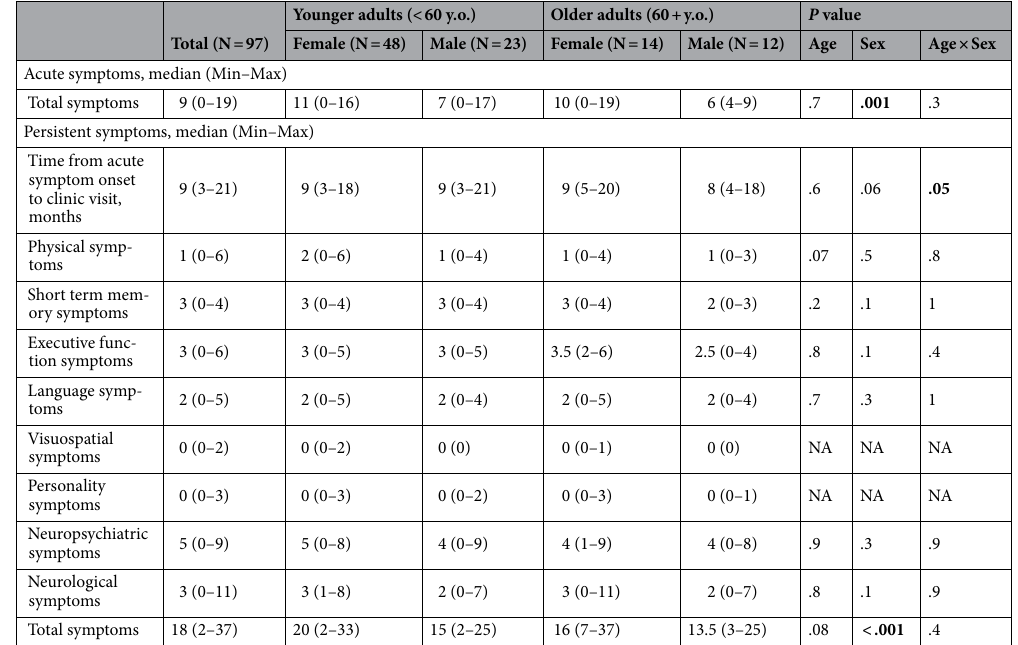
Table 2. Burden of self-reported acute and persistent symptoms stratified by age and sex. Data presented as Median (Min–Max). Symptom burden is quantified as number of self-reported symptoms per person. Negative binomial regression with log link to control for overdispersion adjusted for ICU admission status, combined past medical history, and abnormal brain MRI findings was used. “NA” designation was used where low per- group patient number did not allow for statistical comparisons. NA, not applicable. Significant values are in